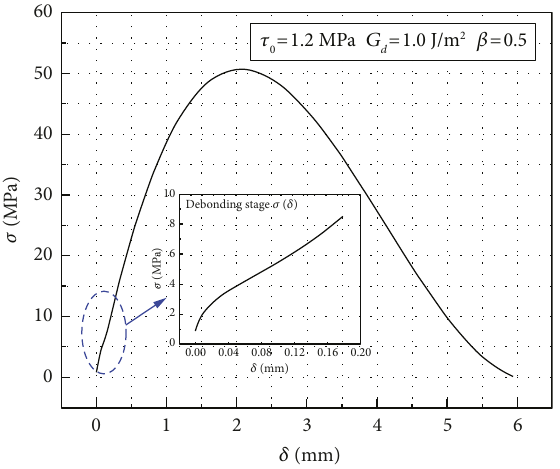
Figure 5: σ - δ curve without fiber rupture